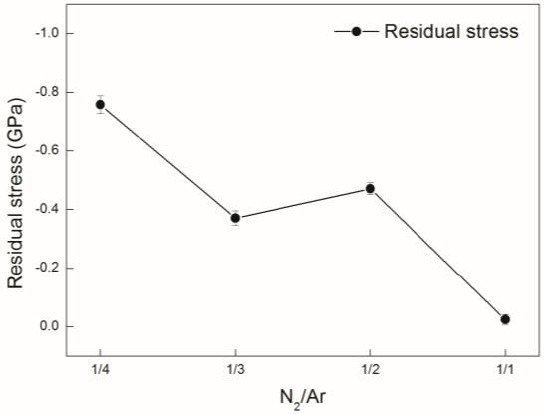
Figure 6. The residual stress of the AlCrSiN coatings as a function of N 2 /Ar flow ratio.